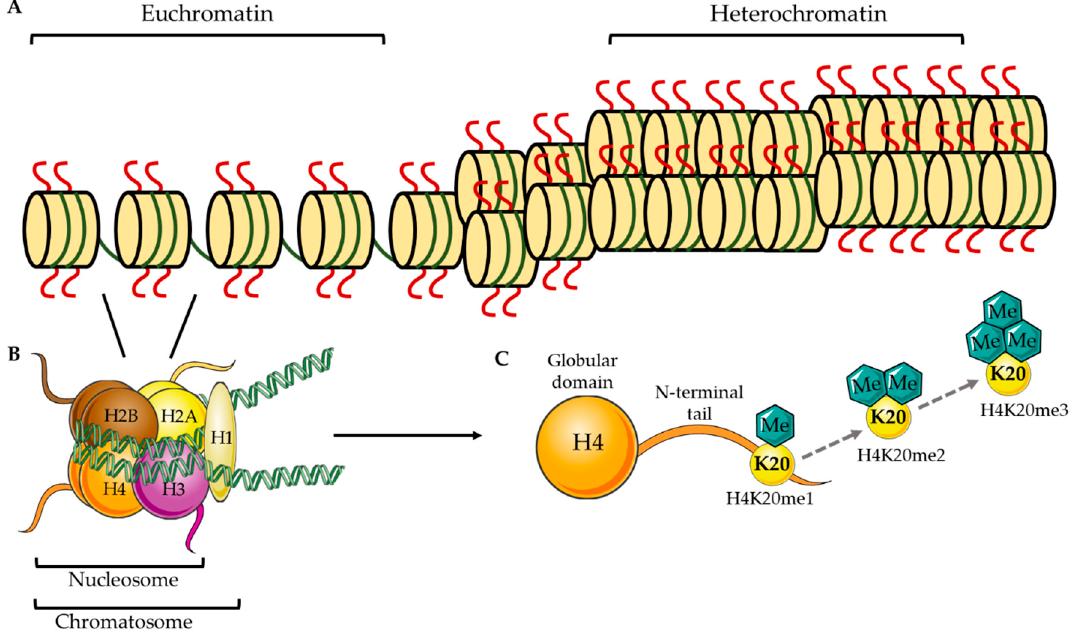
Figure 1. Schematic representation of chromatin organization and H4K20 methylation. ( A ) Models for accessible (euchromatin) vs. condensed (heterochromatin) nucleosomal structures. ( B ) Two each of the histone proteins, H2A, H2B, H3, and H4, come together to form a histone octamer, which is bound by ~1.65 turns of DNA to form the nucleosome. The nucleosome bound by the H1 linker histone forms the chromatosome, which is further compacted to form chromosomes. ( C ) Histone protein 4 has a globular head domain and an N-terminal tail, of which the lysine (K) 20 residue can be mono, di, or tri-methylated.